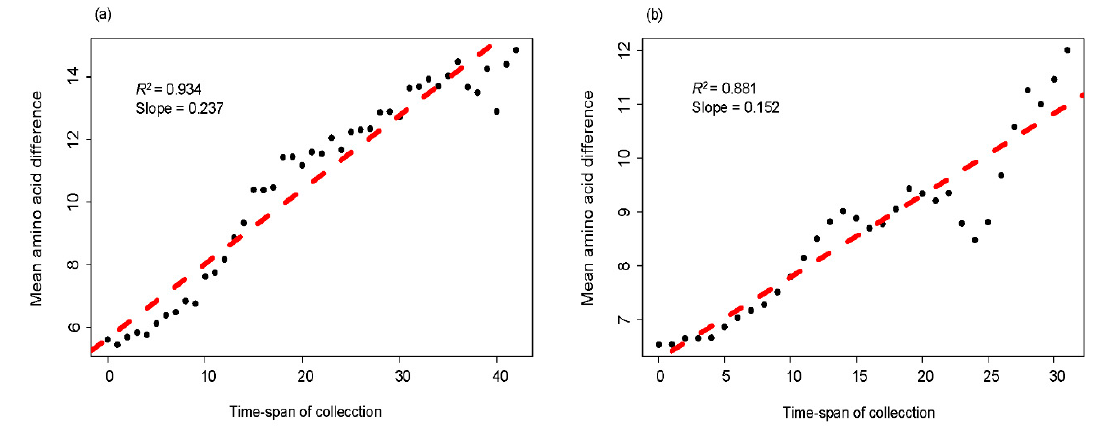
Figure 5. Accumulation plots of amino acid over time of the RVA G1 VP7 gene: ( a ) Lineage I, ( b ) lineage II. The X -axis indicates the timespan of collection, and the Y -axis shows the mean amino acid lineage II. The X ‐ axis indicates the timespan of collection, and the Y ‐ axis shows the mean amino acid di ff erence. The dashed line indicates a linear regression difference. The dashed line indicates a linear regression line.